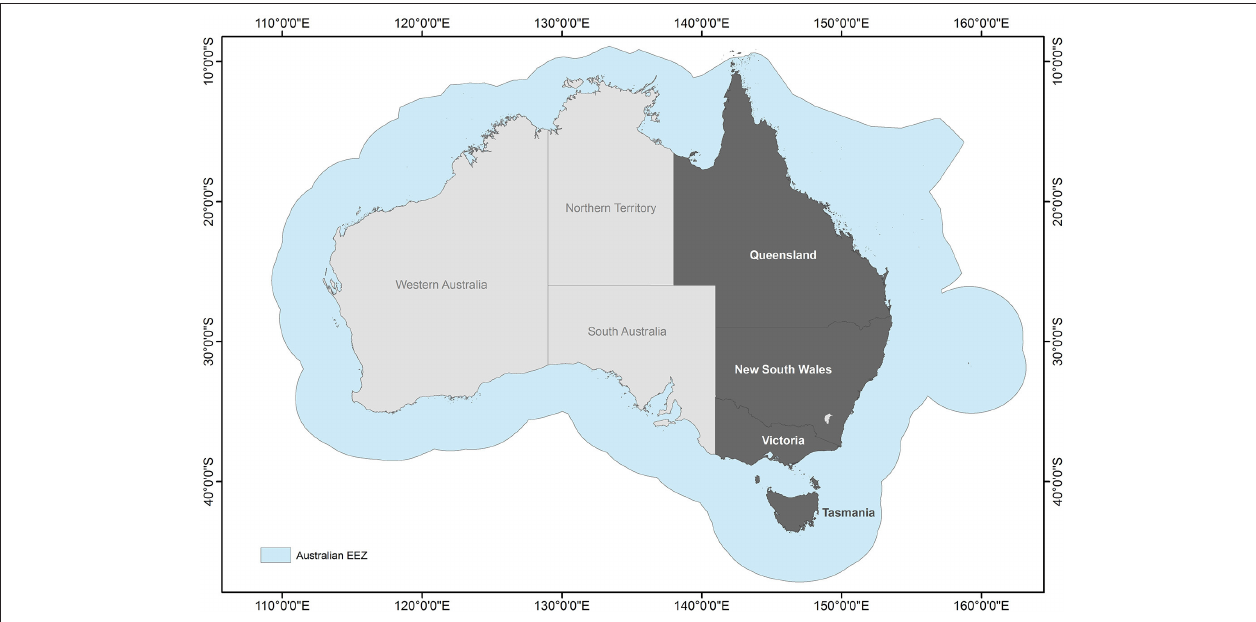
FIGURE 1 | A map of the study area, including the Australian Economic Exclusion Zone (EEZ). The federal government has jurisdiction over the sea out to the edge of the EEZ, while states have jurisdiction out to 3n mi. The East Coast (NSW, Qld, Tas, and Vic) also plays an important role in the distribution of marine turtles, dugongs, humpback whales, and 27 species of migratory shorebirds listed under the Wildlife Conservation Plan for Migratory Shorebirds 2015 ( Australian Government,